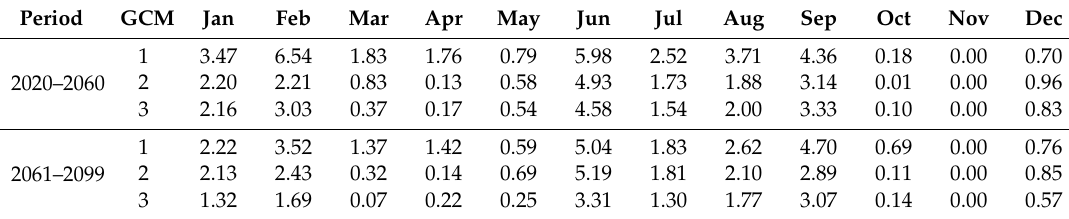
Table 13. RCP 6.0 Future Water Stress Index (WSI) estimations.